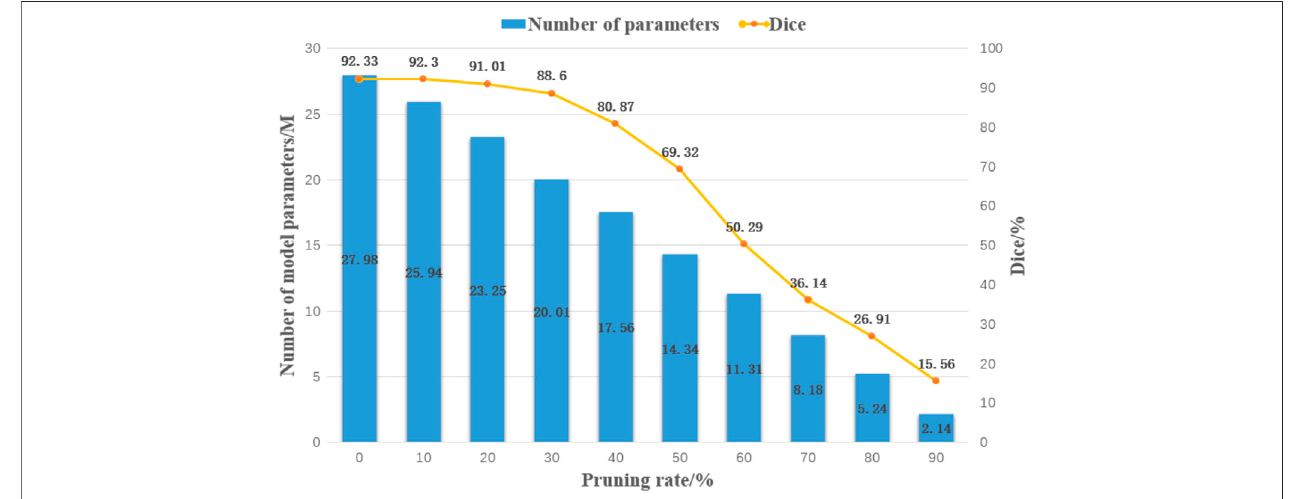
FIGURE 5 | Plot of test results for different pruning